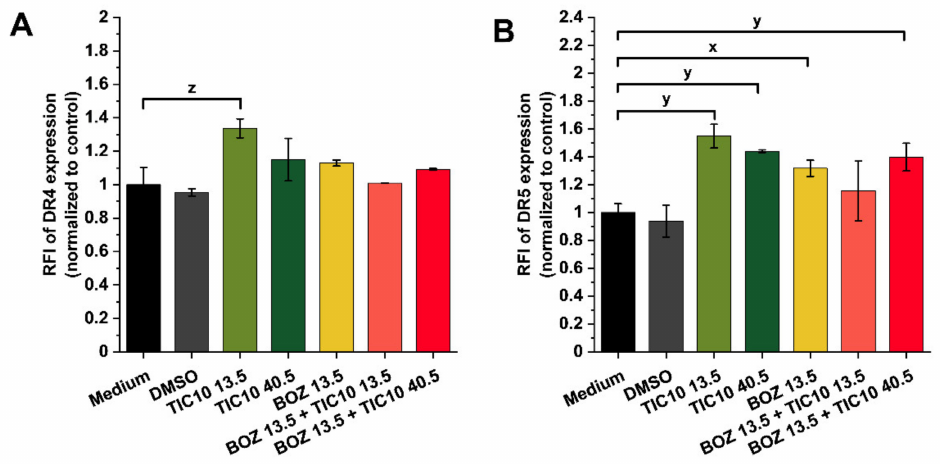
Figure 4. Influence on the death receptor 4 (DR4) and death receptor 5 (DR5) expression of melanoma cell line after 72 h exposure. The ratio of the mean fluorescence intensity (RFI) of ( A ) DR4 expression and ( B ) DR5 expression is reported. The data were normalized to the medium control (RFI = treated cells MFI/control cells MFI; MFI: mean fluorescence intensity). Data are presented as mean values ± standard deviation (SD) ( n = 2). The levels of significance are shown as follows: x: p < 0.05; y: p < 0.01; z: p < 0.001, determined by a one-way ANOVA test followed by Fisher’s LSD post hoc